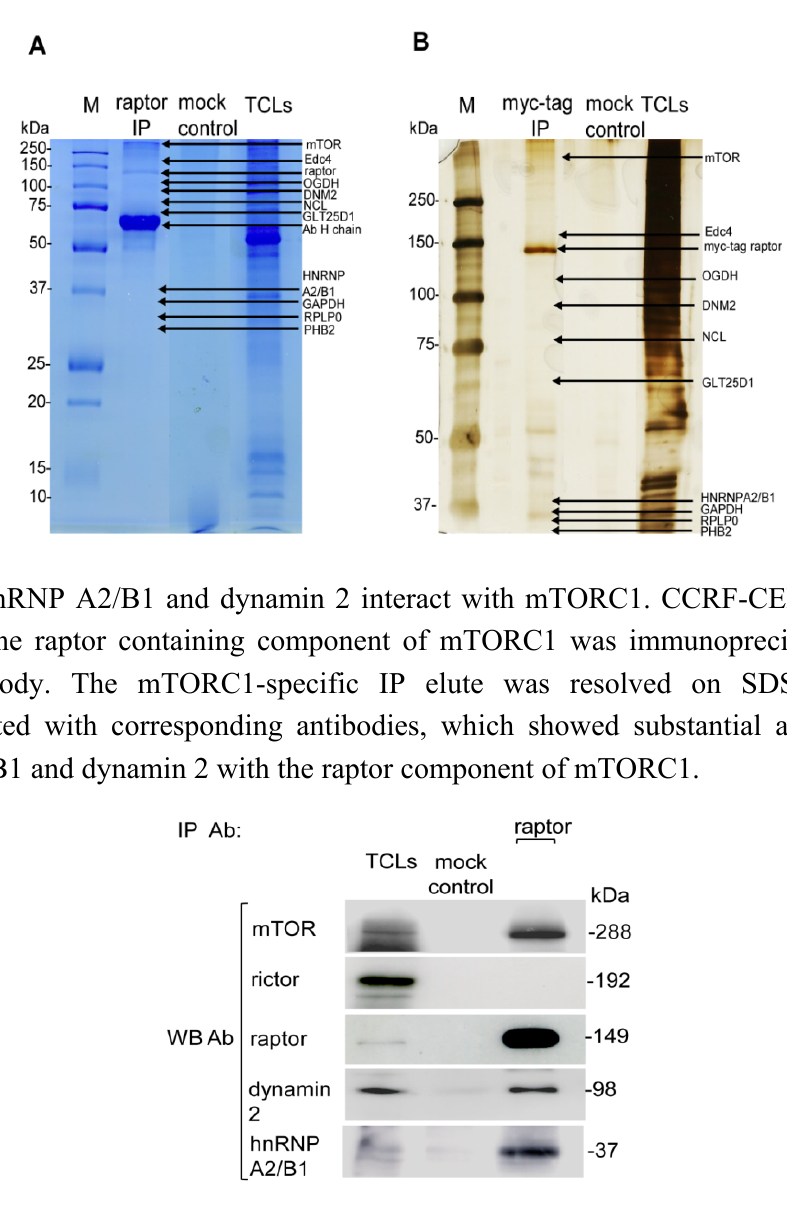
Figure 3. SDS-PAGE analysis of mTORC1 interacting proteins. ( A ) Endogenous